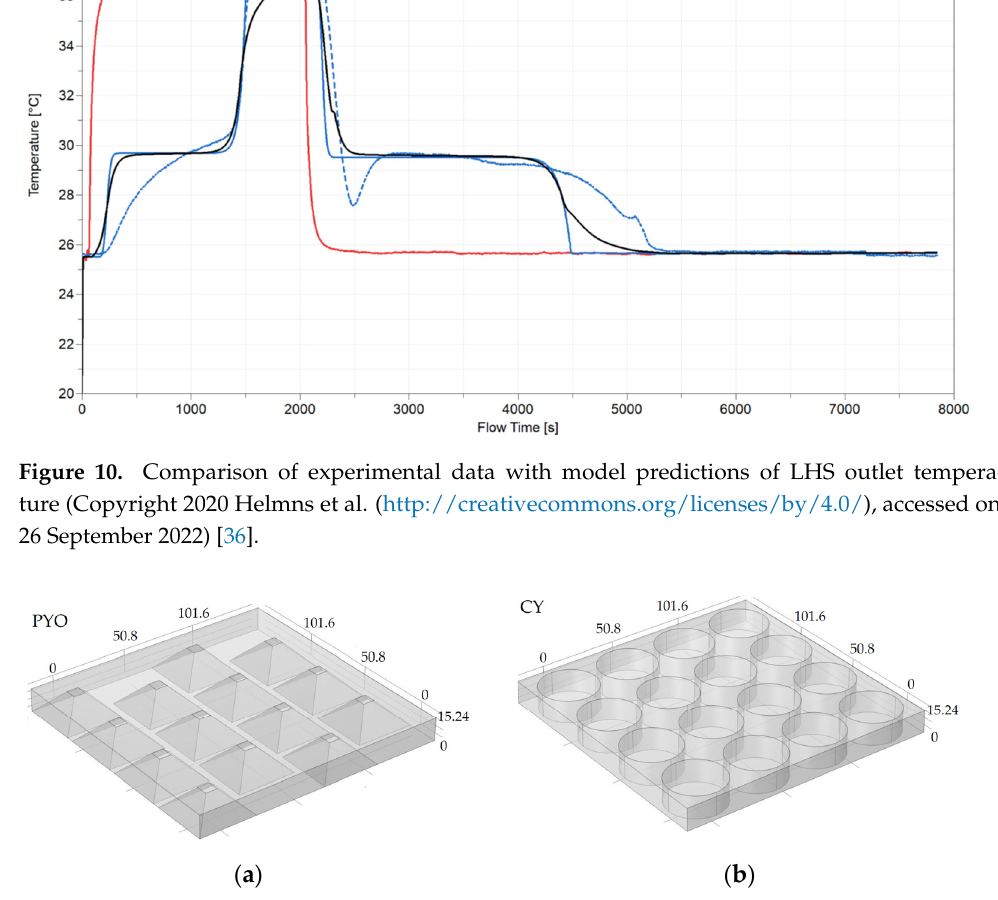
Figure 12. Volume-averaged temperature versus charging time for PCM panels with: PY—pyra- mids, PYO—pyramids with offset, PYR—pyramids with rotation, CY—cylinders, CYO—cylinders with offset (adapted, copyright 2022 Kamidollayev et al. (http://creativecommons.org/li- censes/by/4.0/), accessed on 26 September 2022) [35]. The LHS for domestic hot water studied in Ref. [38] comprised an isolated cylindrical tank (length and diameter of 300 mm and 100 mm) filled with composite medium con- taining microencapsulated paraffin as PCM and graphite fibers into epoxy resin outside two metal tubes for hot water. A model of the nominal energy stored in the PCM based on the enthalpy approach is demonstrated with experimental data in comparison to the common energy balance model Equation (5). For the considered type of encapsulated LHS, the accuracy of the energy balance model can be quite low because the temperature difference of the fluid between inlet and outlet is small and can be close to the absolute error of measurement. The nominal energy model uses temperature distribution in the PCM by measurements into several points. When placed in large PCM containers, the thermocouples can hinder convection and can change the experimental results, which is avoided in the considered case with a microencapsulated PCM. The storage medium vol- ume is divided into n cells and the mean temperature T n is measured in each cell. The energy stored in a cell is calculated by 𝐸 (cid:3041) = ⎩⎪ ⎨ ⎪⎧ 1 2 𝑚(𝑇 (cid:3041) − 𝑇 (cid:3036) )𝑐 (cid:3043),(cid:3006)(cid:3020)(cid:3022) 𝑆 (cid:3041) 𝜋𝑅 (cid:2870)